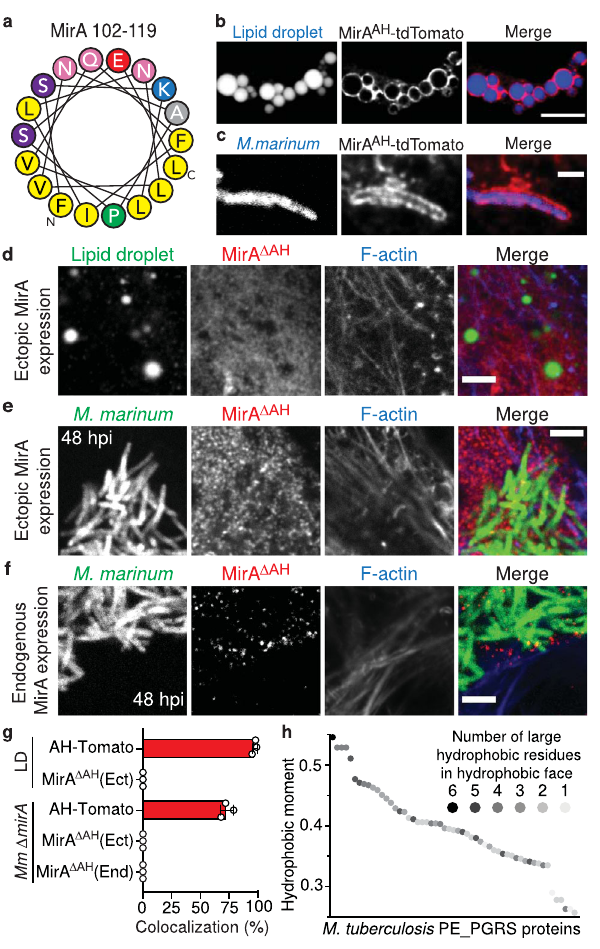
Fig. 5 MirA encodes an amphipathic helix that inserts into the surface of lipid droplets and M. marinum . a A putative amphipathic helix in MirA residues 102 – 119. b The MirA amphipathic helix alone fused to tdTomato ectopically expressed in U2OS cells localizes to the surface of both b eukaryotic lipid droplet organelles (blue; BODIPY 493/503) and c intracellular M. marinum (blue; EBFP2). Scale bars are 2 µ m and 1 µ m,